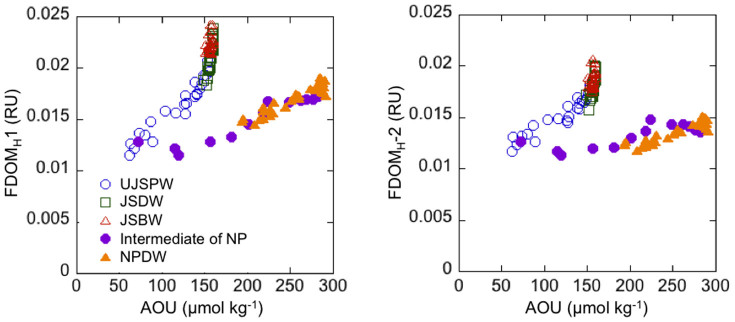
FDOMH-1 and FDOMH-2 versus AOU in individual water masses of the ocean interior.